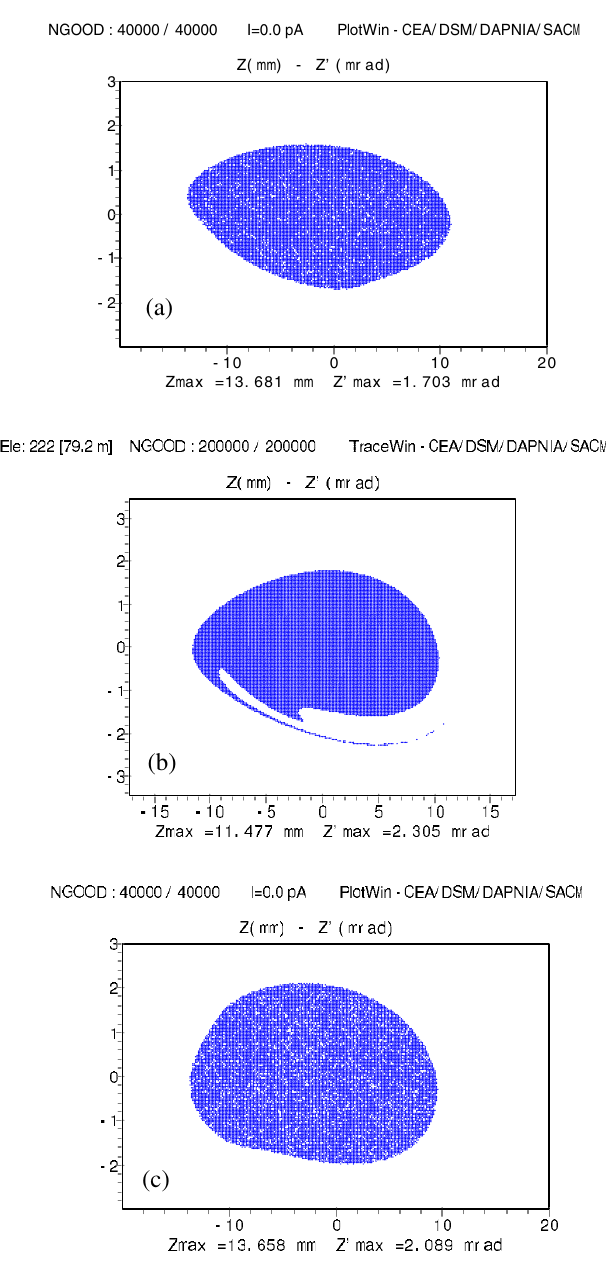
FIG. 3. (Color) Phase space portraits of the beam at the exit for three cases: (a) single frequency ( (cid:7) 0 : 3% ), (b) frequency jump with a matching at transition ( (cid:7) 2% ), (c) frequency jump the mix technique ( (cid:7) 0 : 6% ).